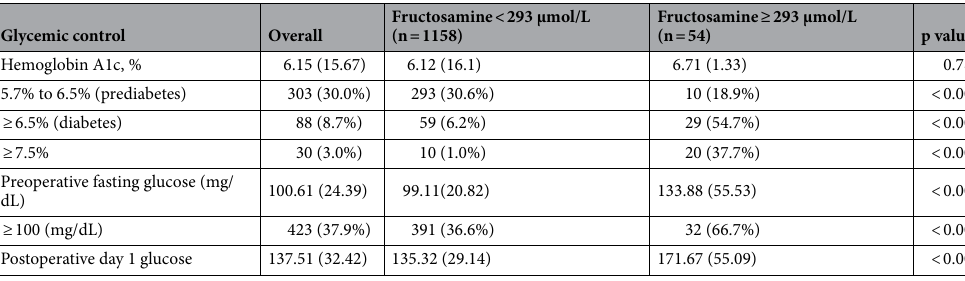
Table 3. Data on glycemic control in patients with fructosamine levels below and above 293 µmol/L. Data are presented as mean values (SD) or as numbers (%). *Excluding diabetic element of